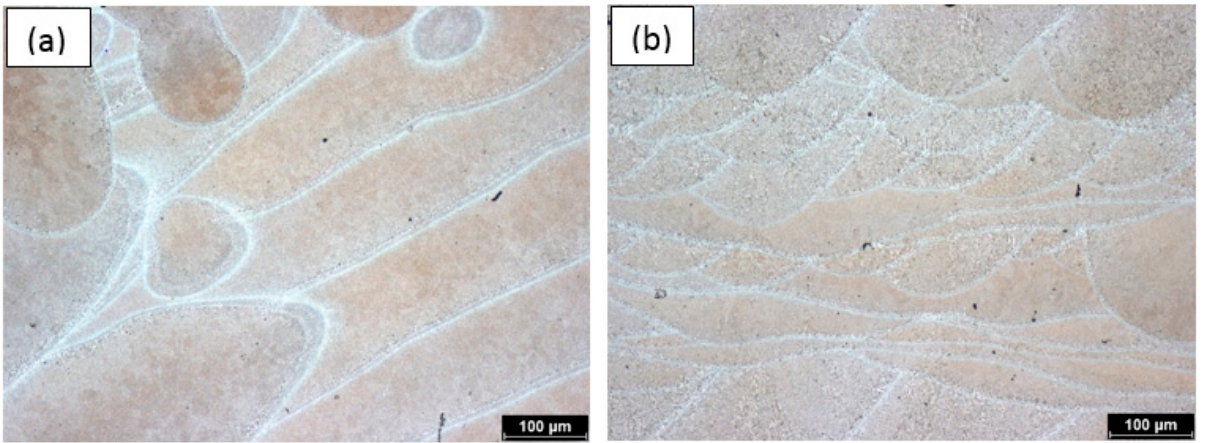
Figure 2. Optical microscopy image of representative microstructure of L-PBF AlSi10Mg alloy in the ( a ) transverse and ( b ) longitudinal cross-sections, as-built state.